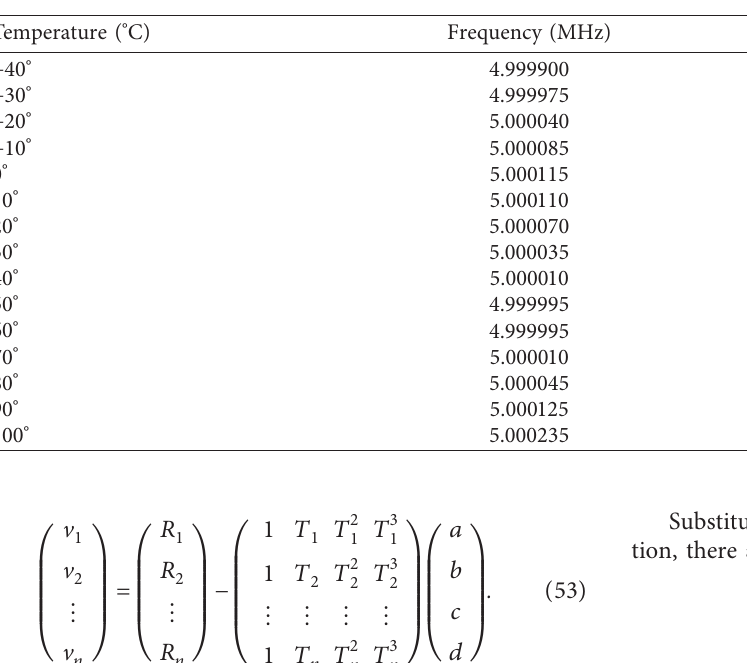
Table 4: Observed